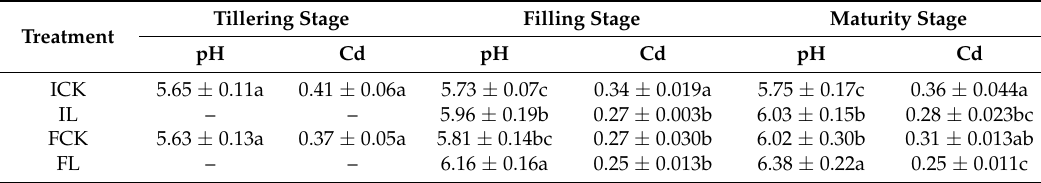
Table 3. Soil pH and available Cd at different growth stages of